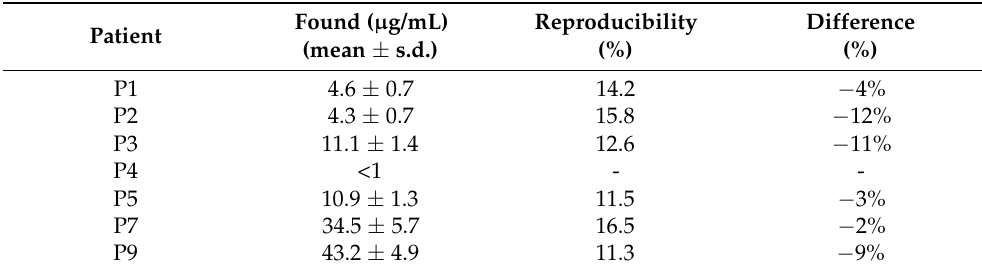
Table 4. Reproducibility and long-term stability ( − 20 ◦ C over four months, with three freeze-thaw cycles) using sample re-analysis of seven patient